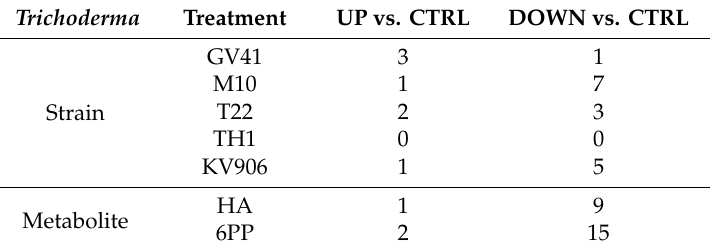
Table 2. Number of metabolites found in olive leaf extracts whose accumulation increased (UP) or decreased (DOWN) compared to the control (CTRL) after 5 field applications with Trichoderma strains or metabolites. Data were analyzed by one-way ANOVA using Mass Profiler software (Agilent Technologies) and only statistically significant compounds ( p < 0.05) that accumulated in the metabolome of treated plants vs. control (fold change ≥ 2.0) have been reported. Trichoderma Treatment UP vs. CTRL DOWN vs.